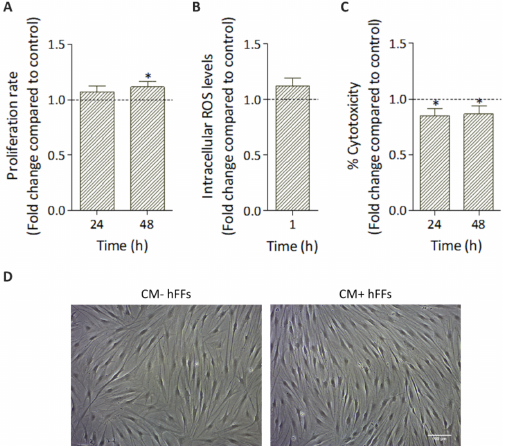
Figure 4. Effect of HC016-CM treatment on hFFs under standard conditions (without UVB irradiation). ( A ) Proliferation rate at 24 and 48 h post-treatment. ( B ) ROS levels measured at 1 h. ( C ) Percentage of cytotoxicity as measured by LDH levels in the culture medium 24 and 48 h post-treatment. ( D ) Phase- contrast images of hFFs 48 h after UVB irradiation (scale bar: 100 µ m). Values were normalized to non-treated cells (dotted line) and expressed as mean ± SD. * p < 0.01 compared with non-treated